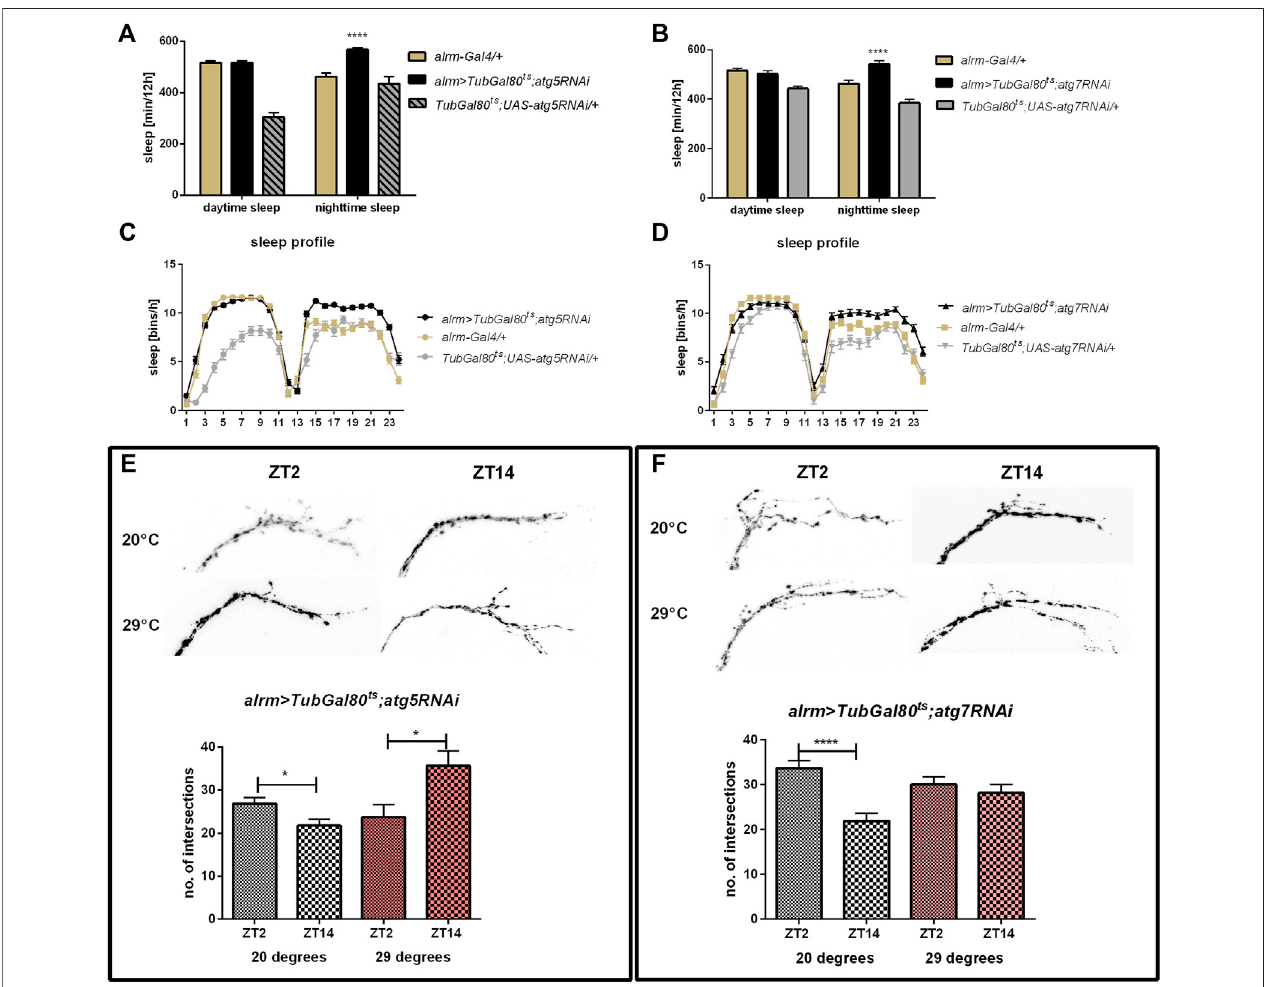
FIGURE 5 | Effect of autophagy disruption in astrocytes-like glia ( alrm marker). Adult speci fi c atg5 (A,C) and atg7 silencing (B,D) increased sleep time during the night. atg5RNAi expression inversed pattern of sLNv arborisations (E) , while atg7RNAi stopped daily changes in intersections number (F) . Statistically signi fi cant differences marked as asterisks * p ≤ 0.05, **** p ≤